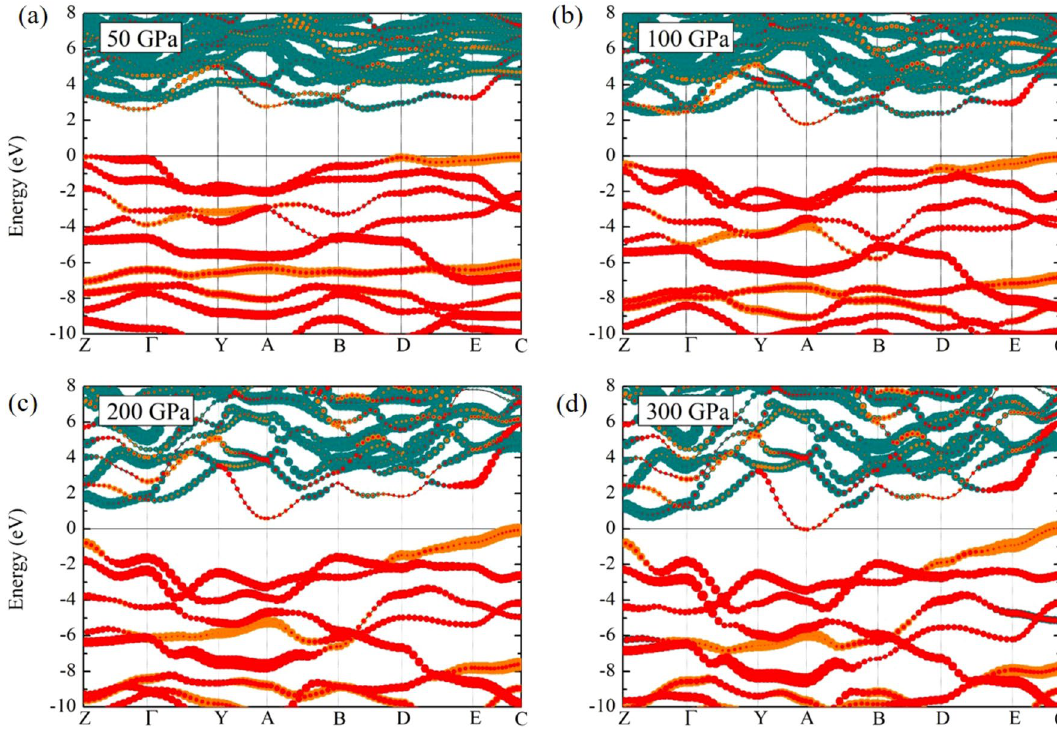
Figure 4. The band structure of CaCH 5 ( a ) the Pm structure at 50 GPa, ( b ) the Pm structure at 100 GPa, ( c ) the Pm structure at 200 GPa, and ( d ) the Pm structure at 300 GPa, respectively. The dark cyan, orange, and red circles represent, respectively, Ca, C, H